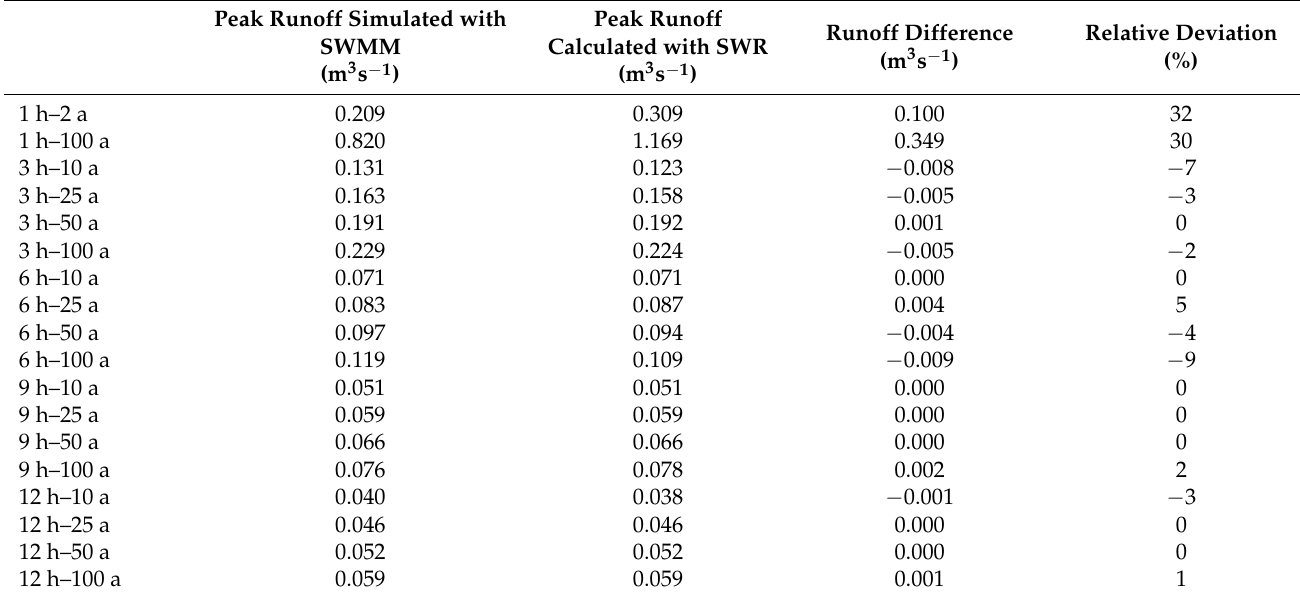
Table 5. Comparison of the simulated (SWMM) and calculated (SWR) direct runoff of the planned residential area (70% sealed).